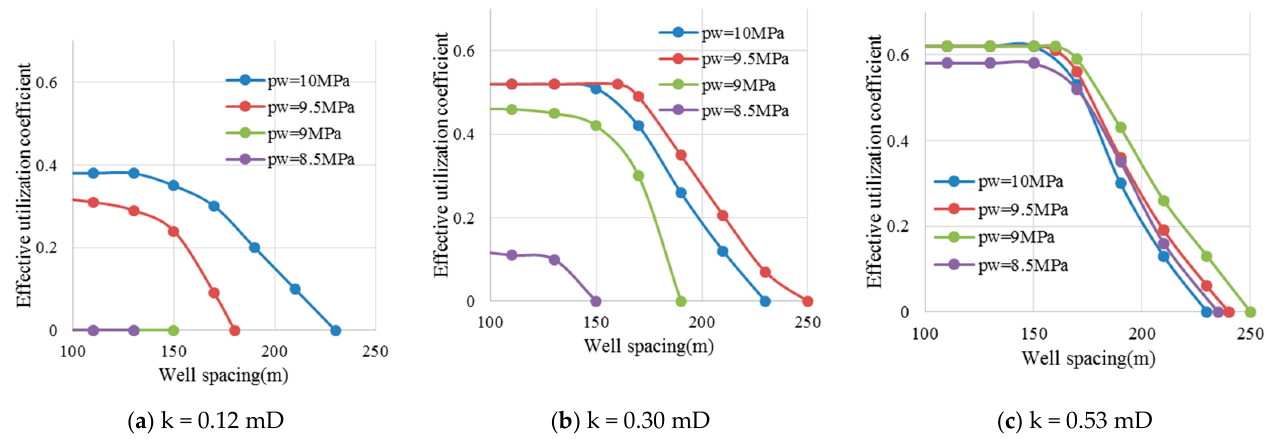
Figure 20. The relationship between the effective utilization coefficient and the well spacing before fracturing.